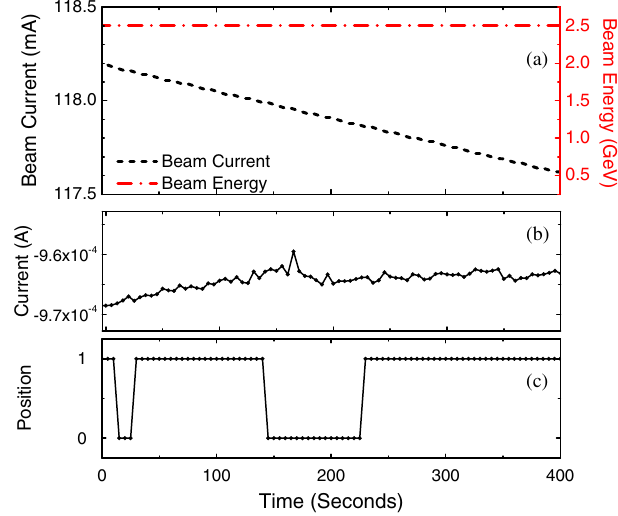
FIG. 12. Evolution of the clearing electrode signal at an applied bias voltage of 200 V while changing the position of the photon cup, as a function of time during 400 s of KARA ’ s e − beam storage of (a) beam energy (red line) and beam current (black line) and (b),(c) current measured at the clearing electrode. (d) Position of the photon cup (1, at the photon trajectory and 0, aside the photon